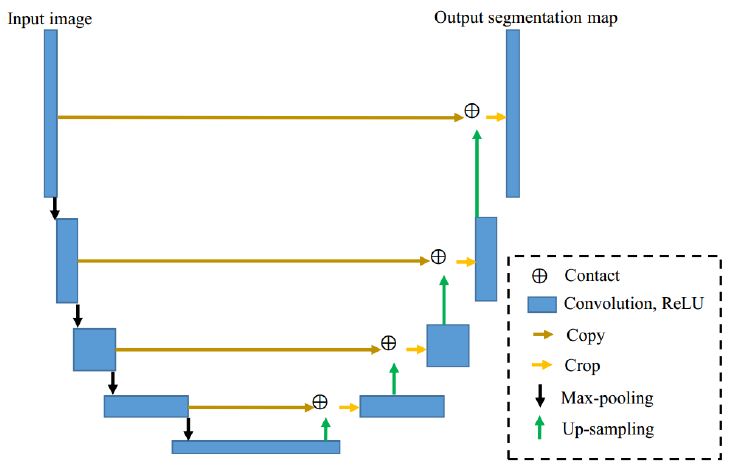
Figure 1. U-Net network structure. Note that the figure is designed according to Reference [30].